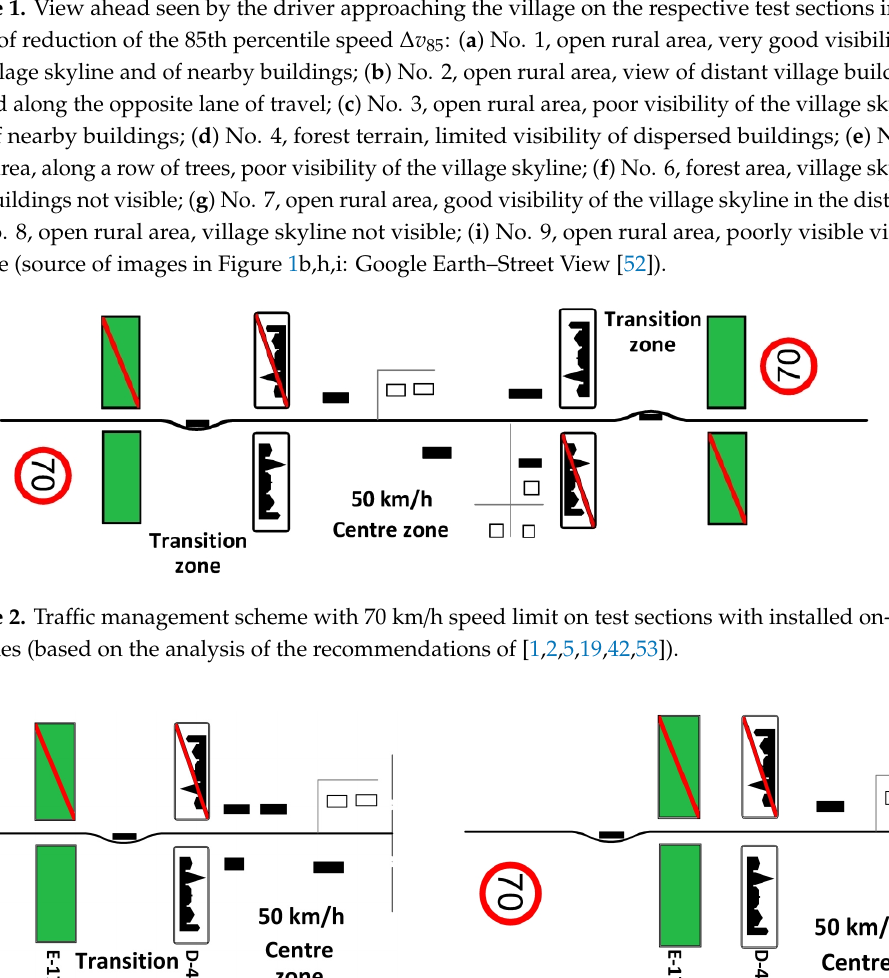
Figure 1. View ahead seen by the driver approaching the village on the respective test sections in the Figure 1 . Cont. order of reduction of the 85th percentile speed ∆ v 85 : ( a ) No. 1, open rural area, very good visibility of the village skyline and of nearby buildings; ( b ) No. 2, open rural area, view of distant village buildings located along the opposite lane of travel; ( c ) No. 3, open rural area, poor visibility of the village skyline and of nearby buildings; ( d ) No. 4, forest terrain, limited visibility of dispersed buildings; ( e ) No. 5, rural area, along a row of trees, poor visibility of the village skyline; ( f ) No. 6, forest area, village skyline and buildings not visible; ( g ) No. 7, open rural area, good visibility of the village skyline in the distance; ( h ) No. 8, open rural area, village skyline not visible; ( i ) No. 9, open rural area, poorly visible village skyline (source of images in Figures 1b,h,i: Google Earth–Street View [52]).